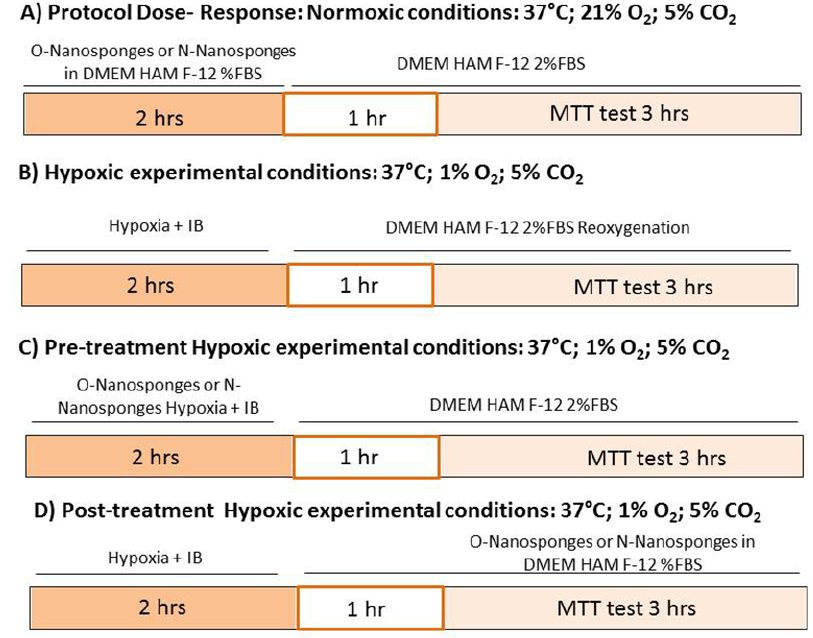
Figure 1. Experimental protocols and 3-(4,5-dimethylthiazol-2-yl)-2,5-diphenyltetrazolium bromide (MTT) test. IB: ischemic buffer. ( A – D ) are different experimental conditions.